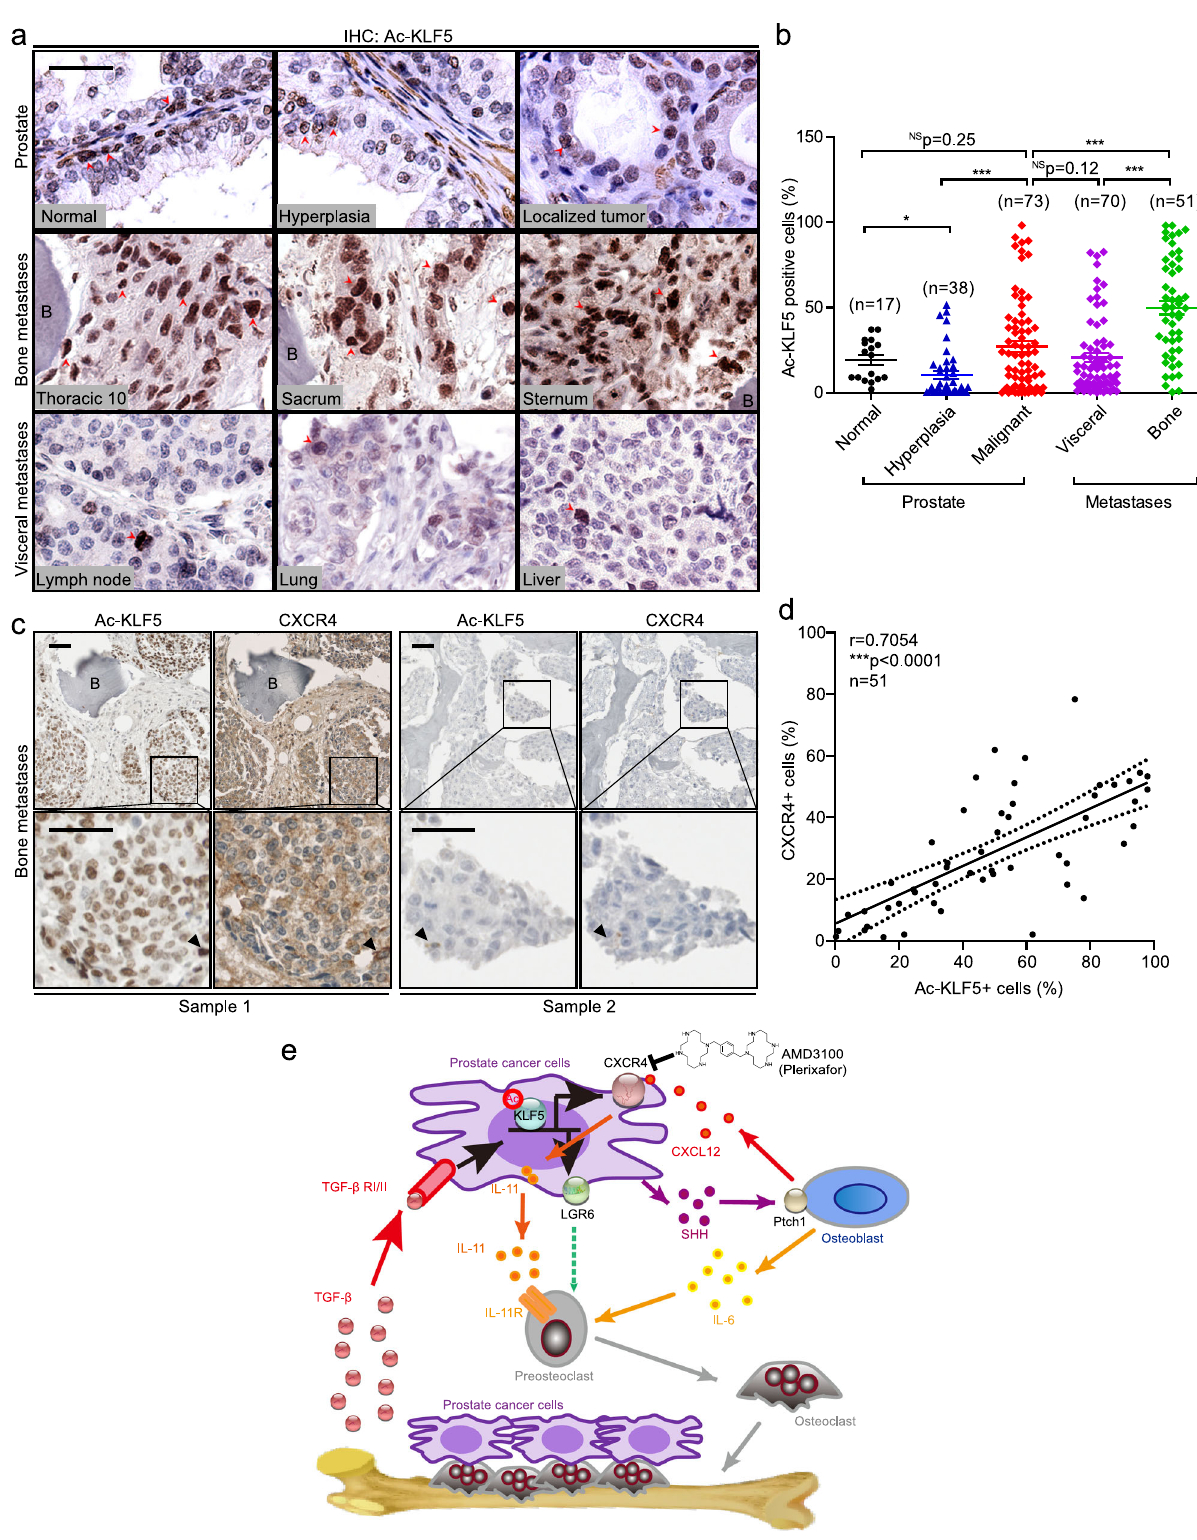
trials are warranted to test whether combined docetaxel and plerixafor treatment provides survival bene fi ts to patients with Ac-KLF5-expressing bone metastases, and detection of Ac-KLF5 would be bene fi cial for optimizing therapies. Finally, PCa cells expressing different forms of KLF5 and their subcutaneous and tibial xenograft models established in this study could prove useful for the development of therapies targeting bone